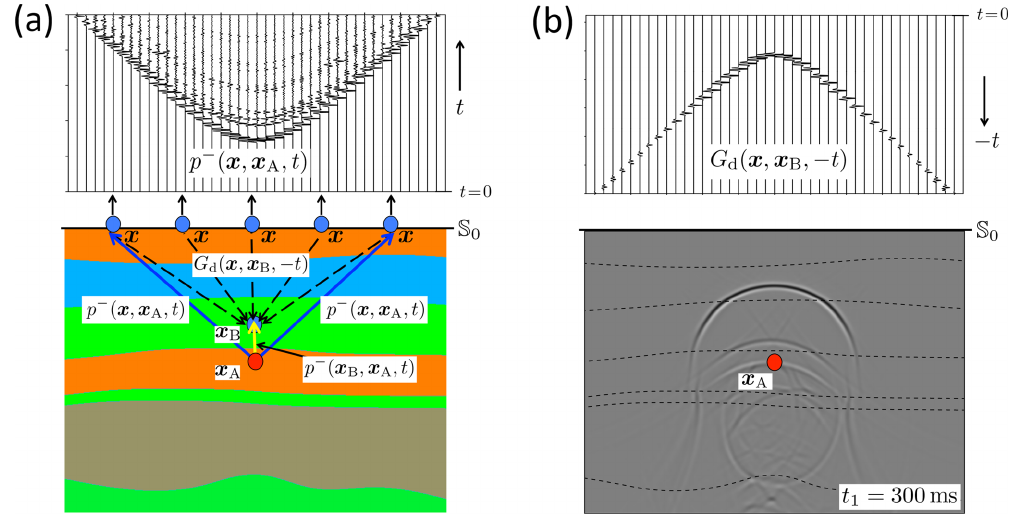
Figure 6. Principle of back propagation. (a) The upgoing wave field p − ( x , x A ,t) at the surface S 0 and illustration of its back propagation to x B inside the medium. (b) The back propagation operator G d ( x , x B , − t) (for variable x along S 0 and fixed x B ) and a snapshot of the back propagated wave field p − ( x B , x A ,t) at t 1 = 300ms for all x B